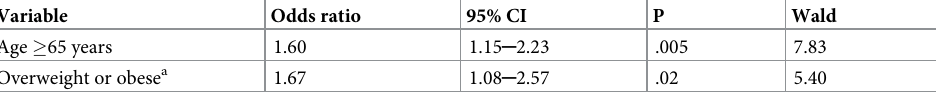
Table 4. Multivariable analysis of factors associated with pre-diabetes according to diagnosis by HbA 1c using WHO-IEC classification.